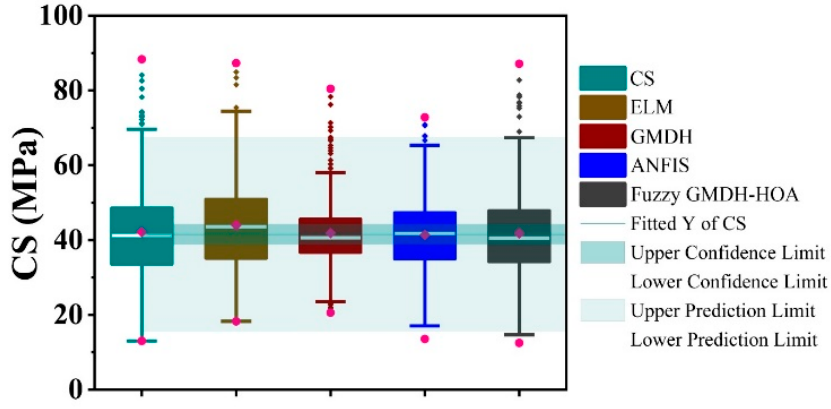
Figure 9. Boxplot of proposed AI predictive models.